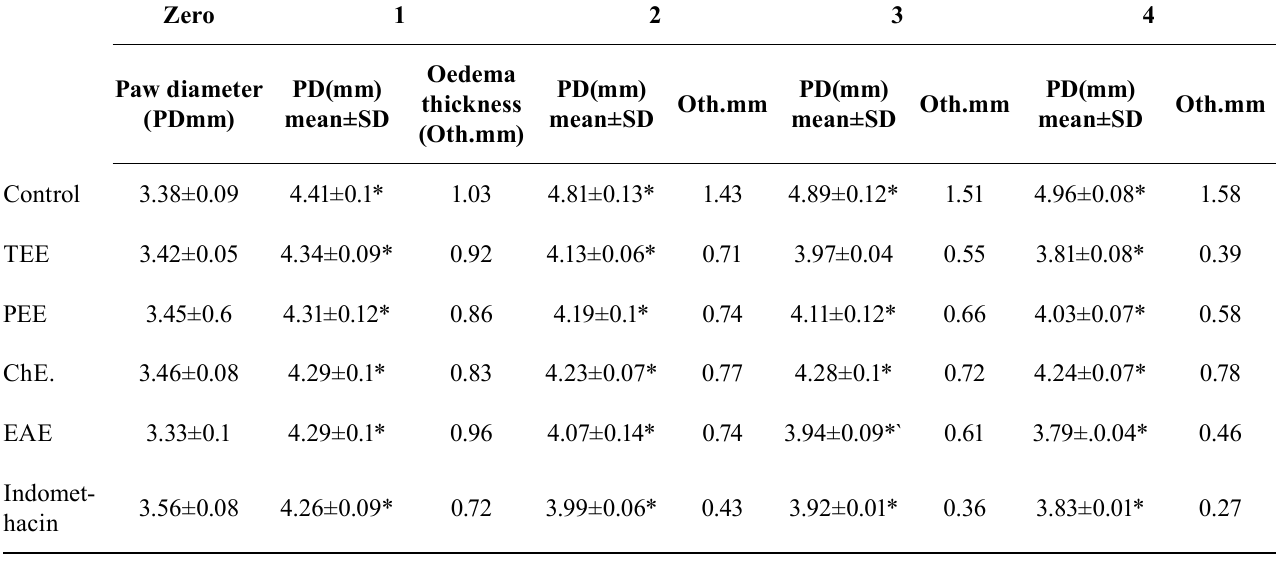
TABLE V – A cute anti-inflammatory activity of the TEE extract and sucessive extracts of A. fraxinifoliu s bark